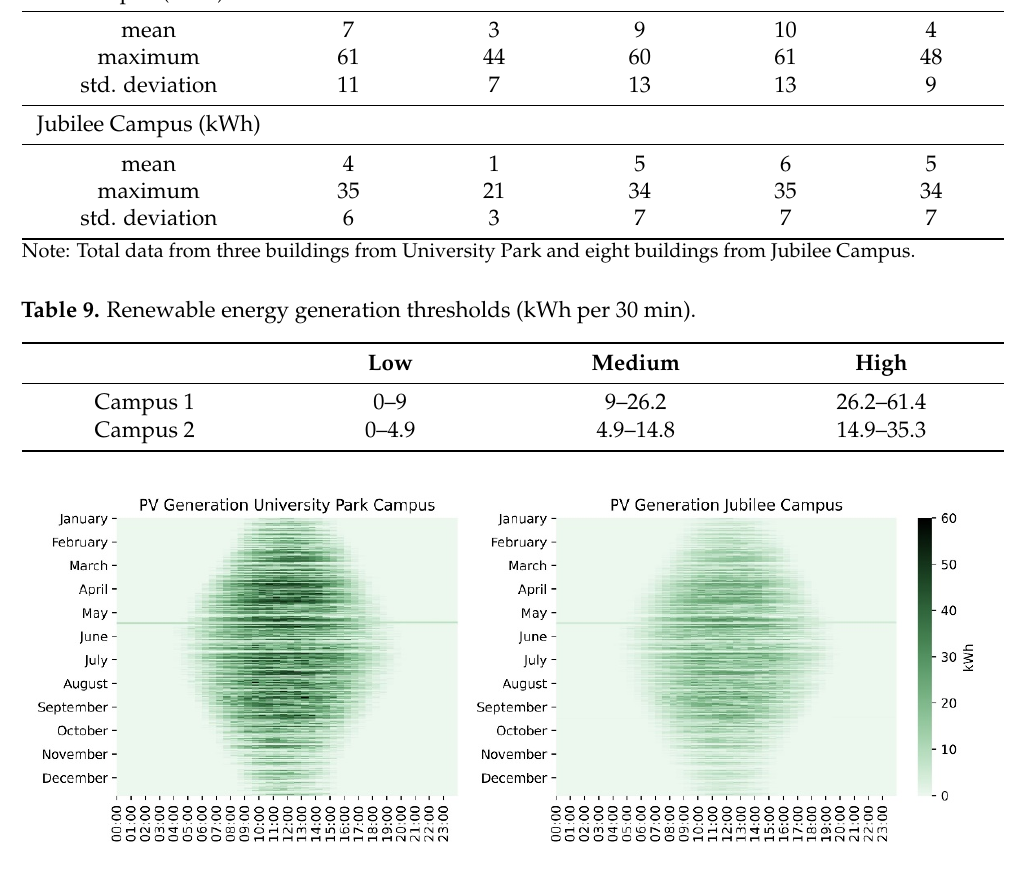
Figure 9. Half-hourly renewable energy generation from photovoltaics at University Park and Jubilee campuses, UK.